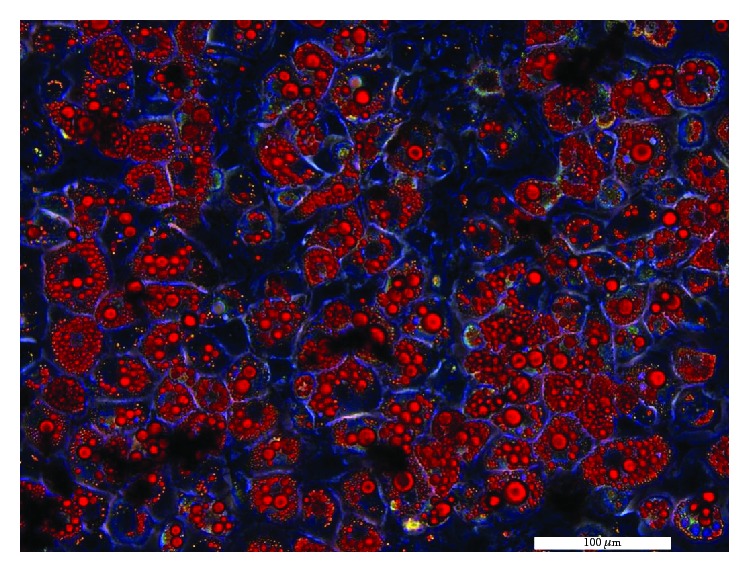
Differentiated and mature 3T3-L1 adipocytes (Oil Red O staining).